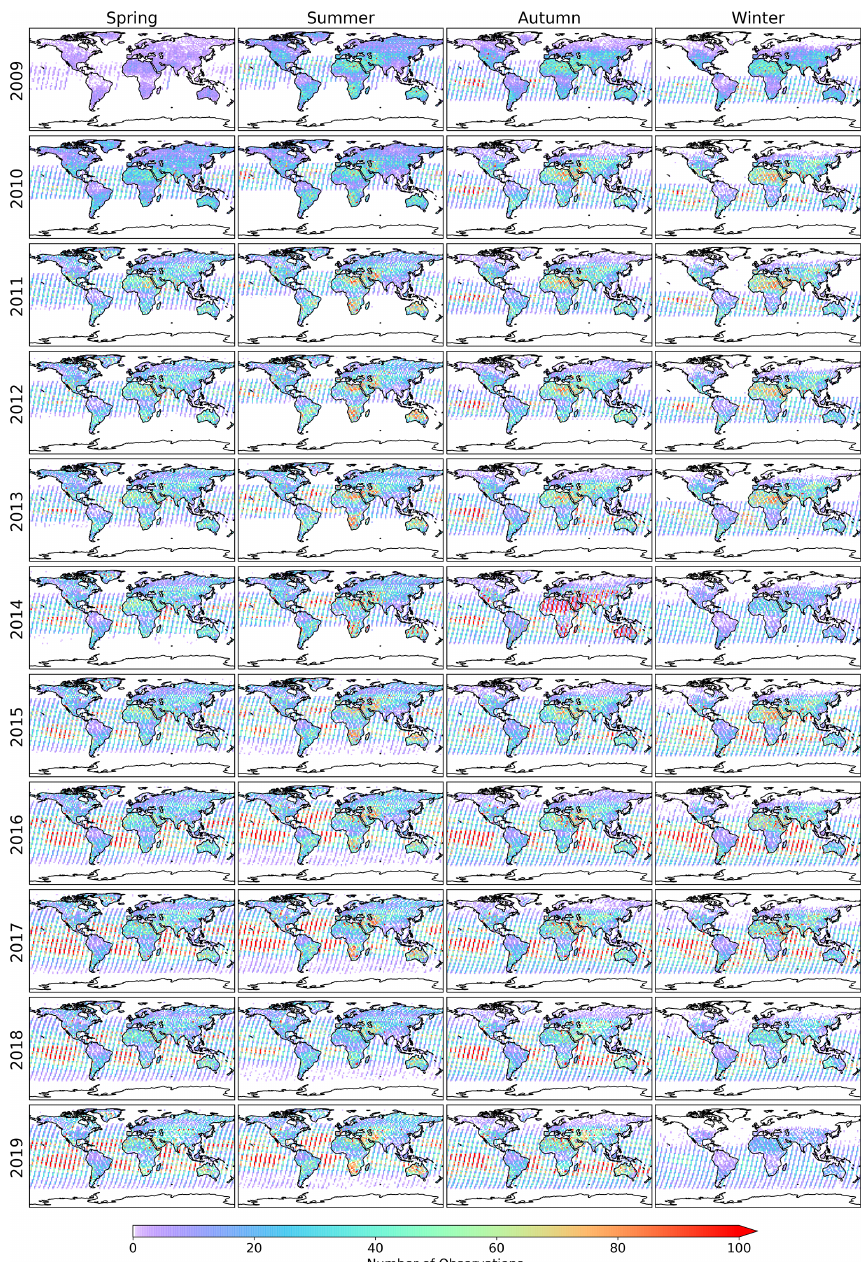
Figure E3. Figure showing the number of successful GOSAT XCH 4 measurements per 2 ◦ latitude–longitude bin from April 2009 to De- cember 2019 separated into seasons – spring (MAM), summer (JJA), autumn (SON) and winter